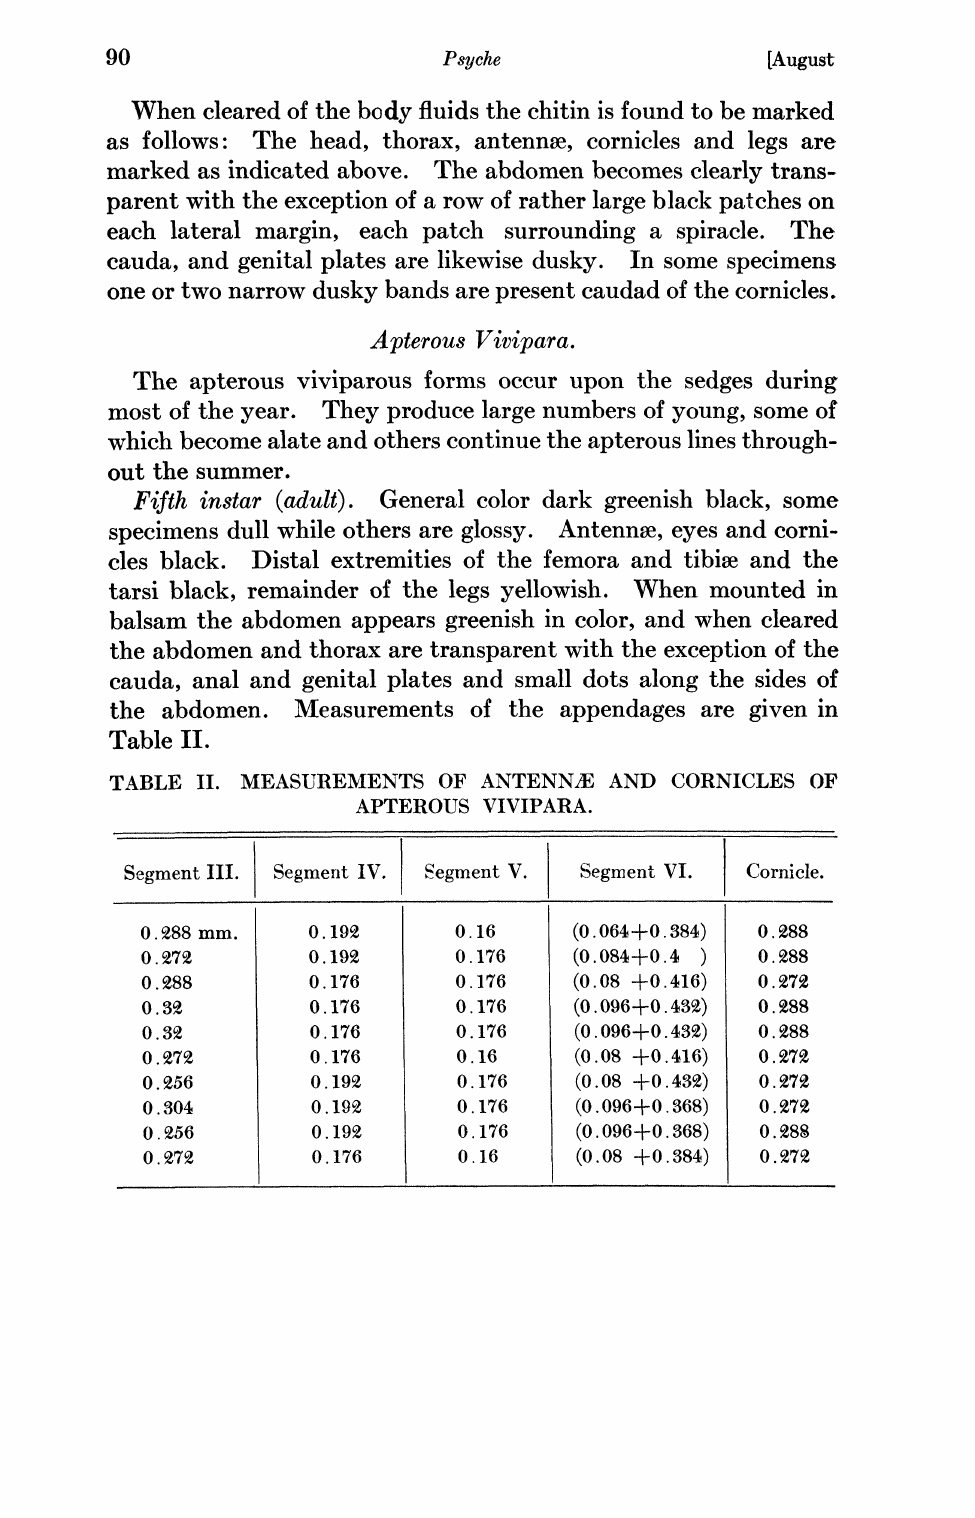
TABLE II. MEASUREMENTS OF ANTENNAE AND CORNICLES OF APTEROUS VIVIPARA. Segment